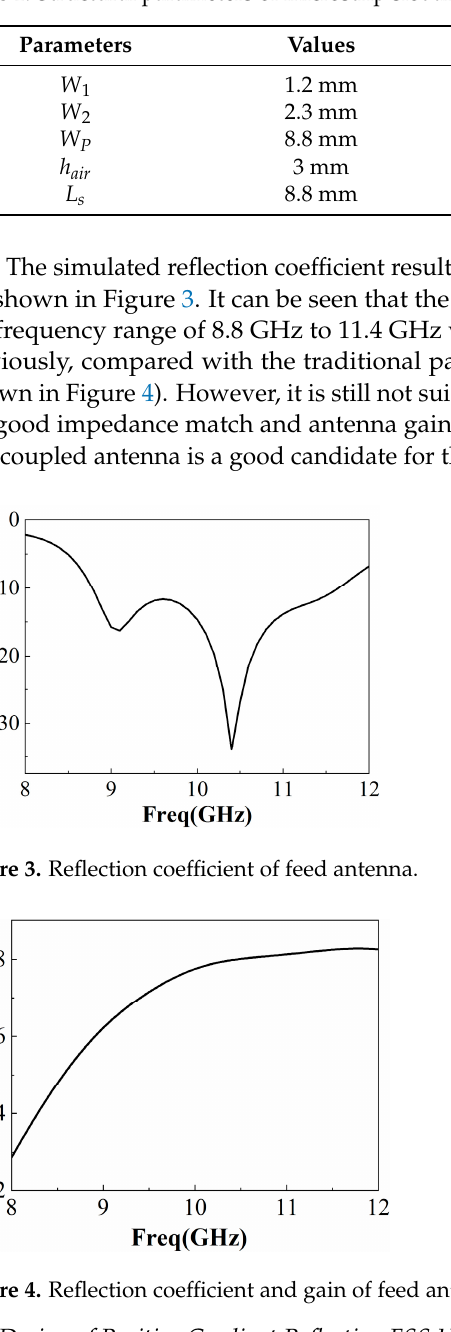
Table 1. Structural parameters of microstrip slot antenna.